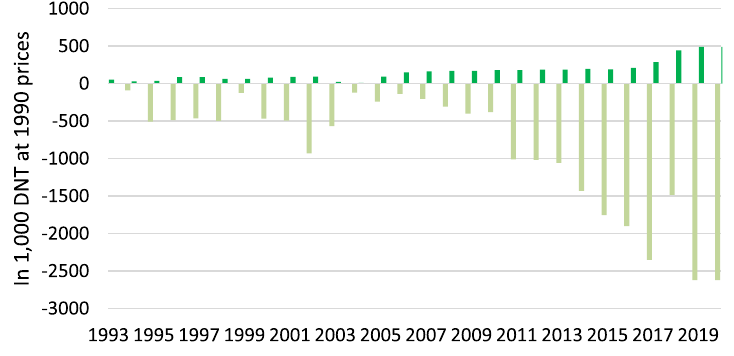
Fig. 6 Balance of trade by product and customs regime. Source Compiled by the author from data collected from several issues of the Statistical Yearbook of Tunisia (NIS 2020)